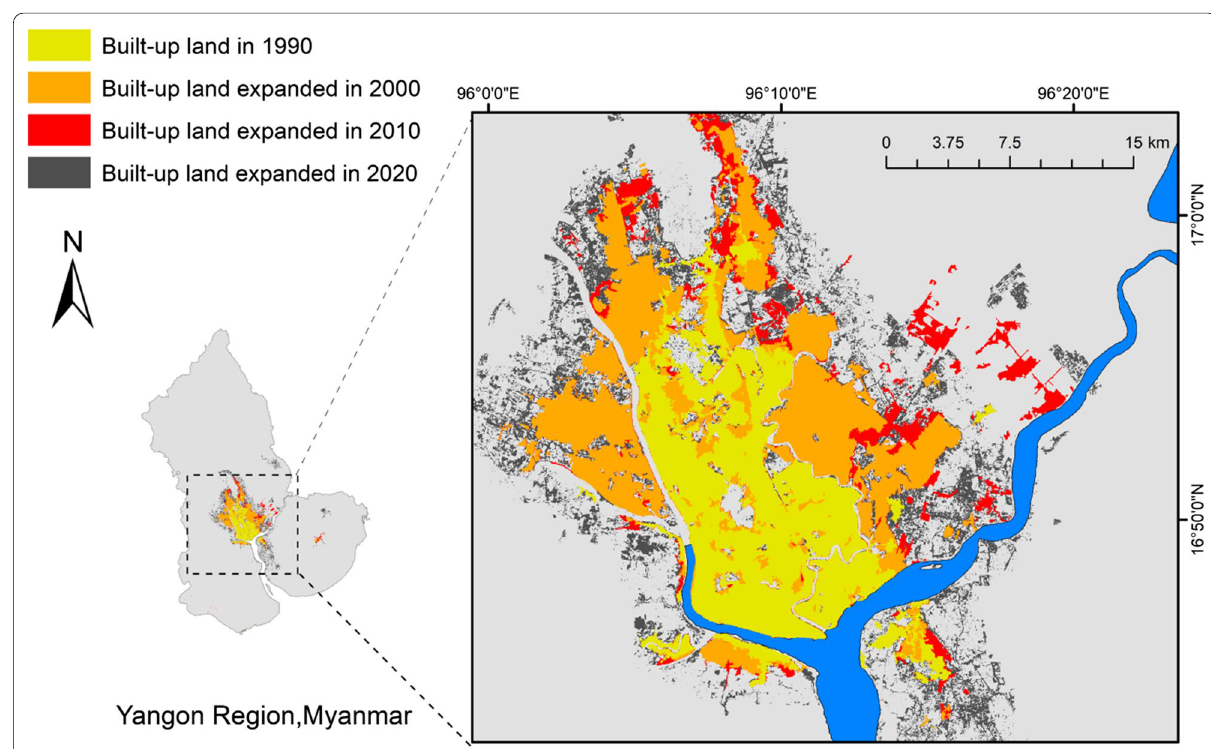
Fig. 2 Urban expansion of Yangon, Myanmar during 1990–2020. The urban built-up area expanded from 161 km 2 in 1990 to 289 km 2 in 2000, 329 km 2 in 2010, and 739 km 2 in